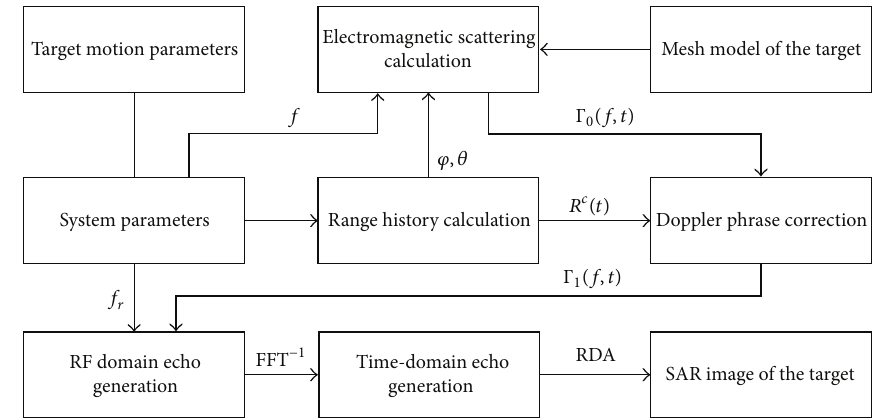
Figure 7: Block scheme of the simulation method.